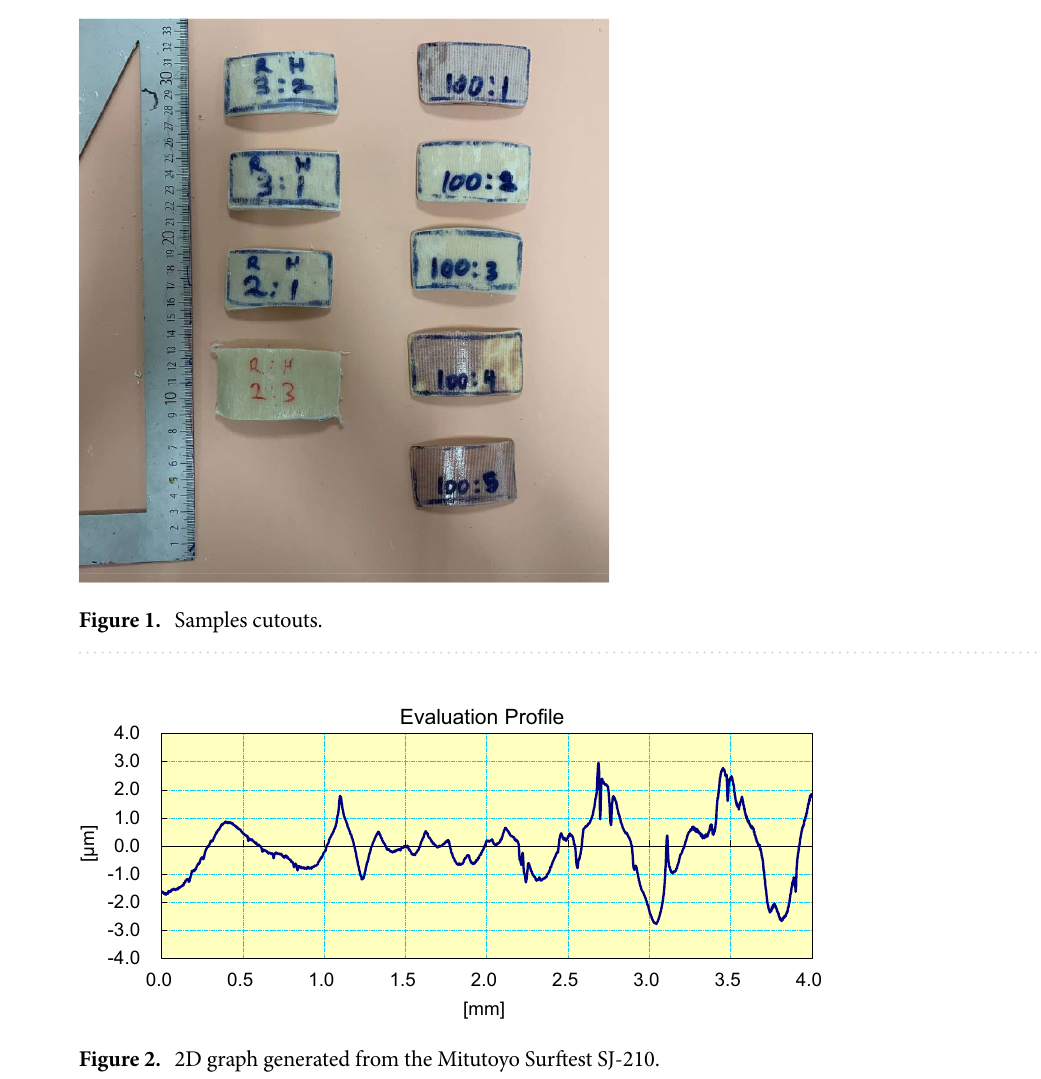
Figure 2. 2D graph generated from the Mitutoyo Surftest SJ-210.